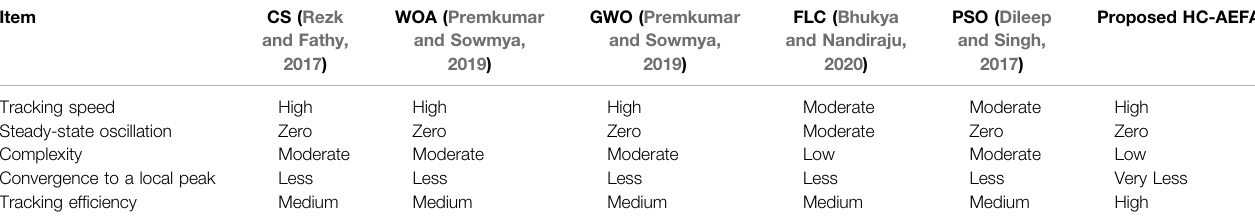
TABLE 7 | Comparison of the HC-AEFA performance in MPPT solution with previous studies.